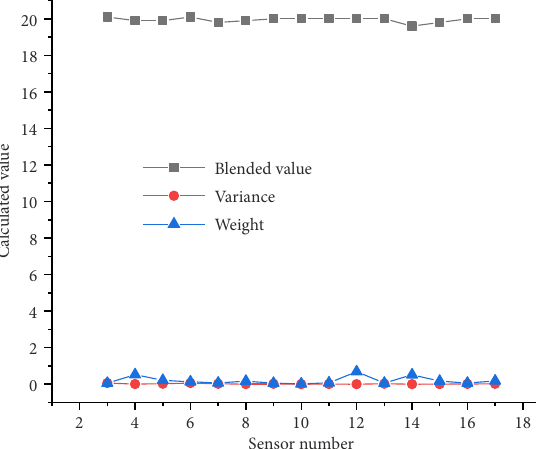
Figure 11. Fusion value, variance, and weight of the data of sensors based on the proposed improved algorithm